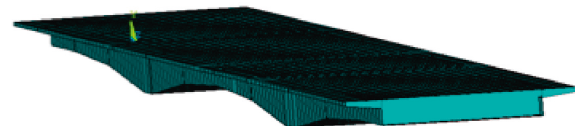
Figure 8: Bridge finite element